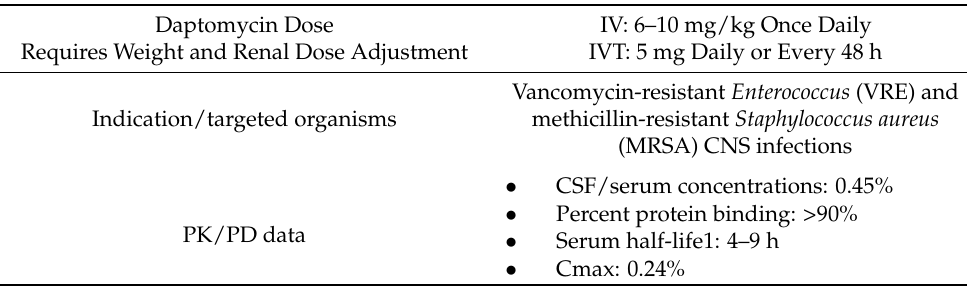
Table 4. Daptomycin dosing and PK/PD